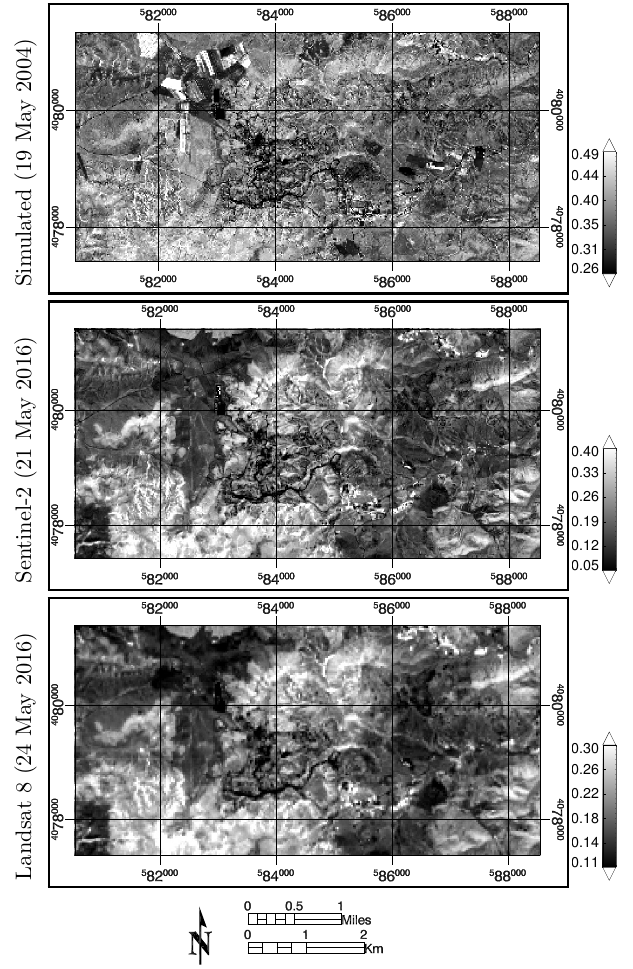
Figure 4. Normalized Difference Vegetation Index (NDVI) image result of the simulated Sentinel-2A MSI data cube dating from 2004 ( top ), the Sentinel-2A MSI dating from 2016 ( centre ), and the Landsat 8 OLI ( bottom ). The images shown are histogram stretched from 2%–98%. The town of Rodalquilar in the centre has relatively low NDVI values, while the hills north and south of it have the highest values. Other high values, such as those associated with the fields in the northeastern part of the simulated image, seem to be related to agricultural activity and not to